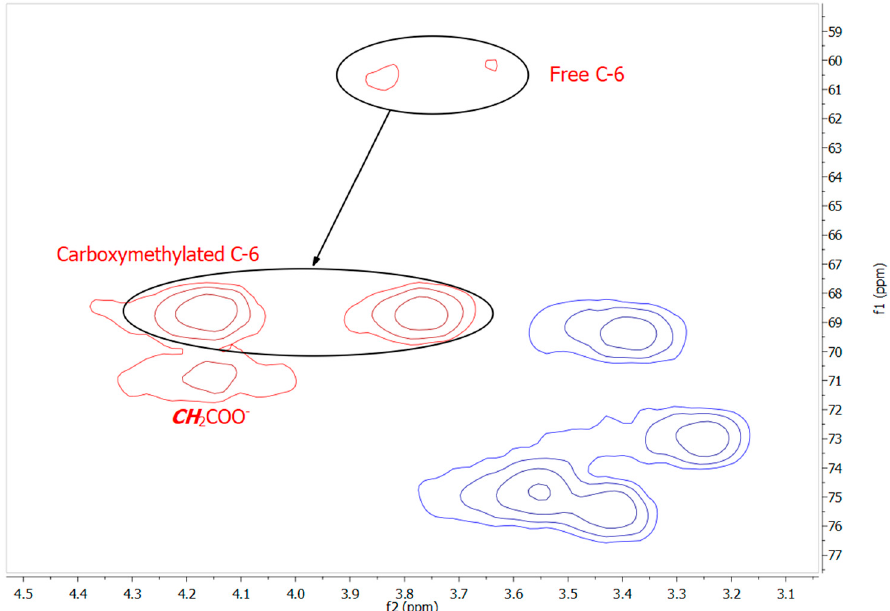
Figure 4. 1 H- 13 C HSQC spectrum of CM-BOT (C-6 region). Free C-6, carboxymethylated C-6, and